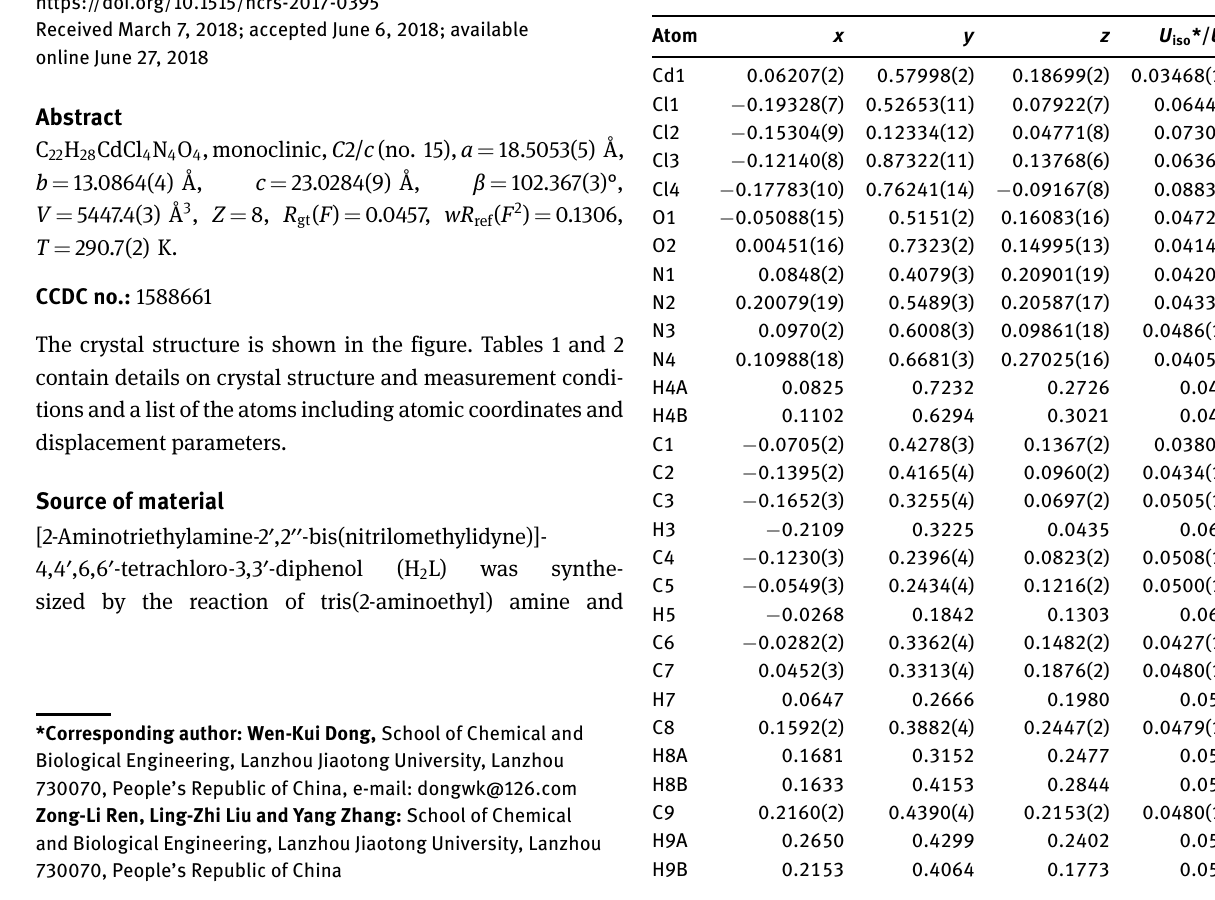
Table 2: Fractional atomic coordinates and isotropic or equivalent isotropic displacement parameters (Å 2